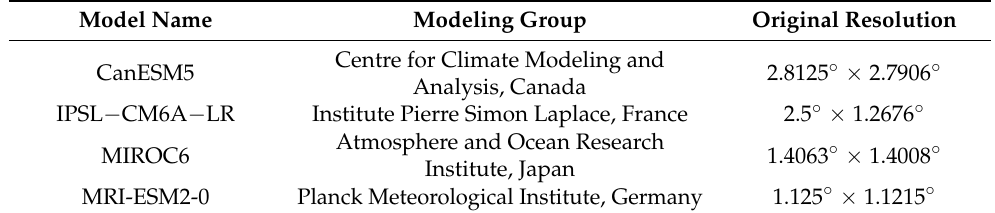
Table 2. Detailed information on CMIP6